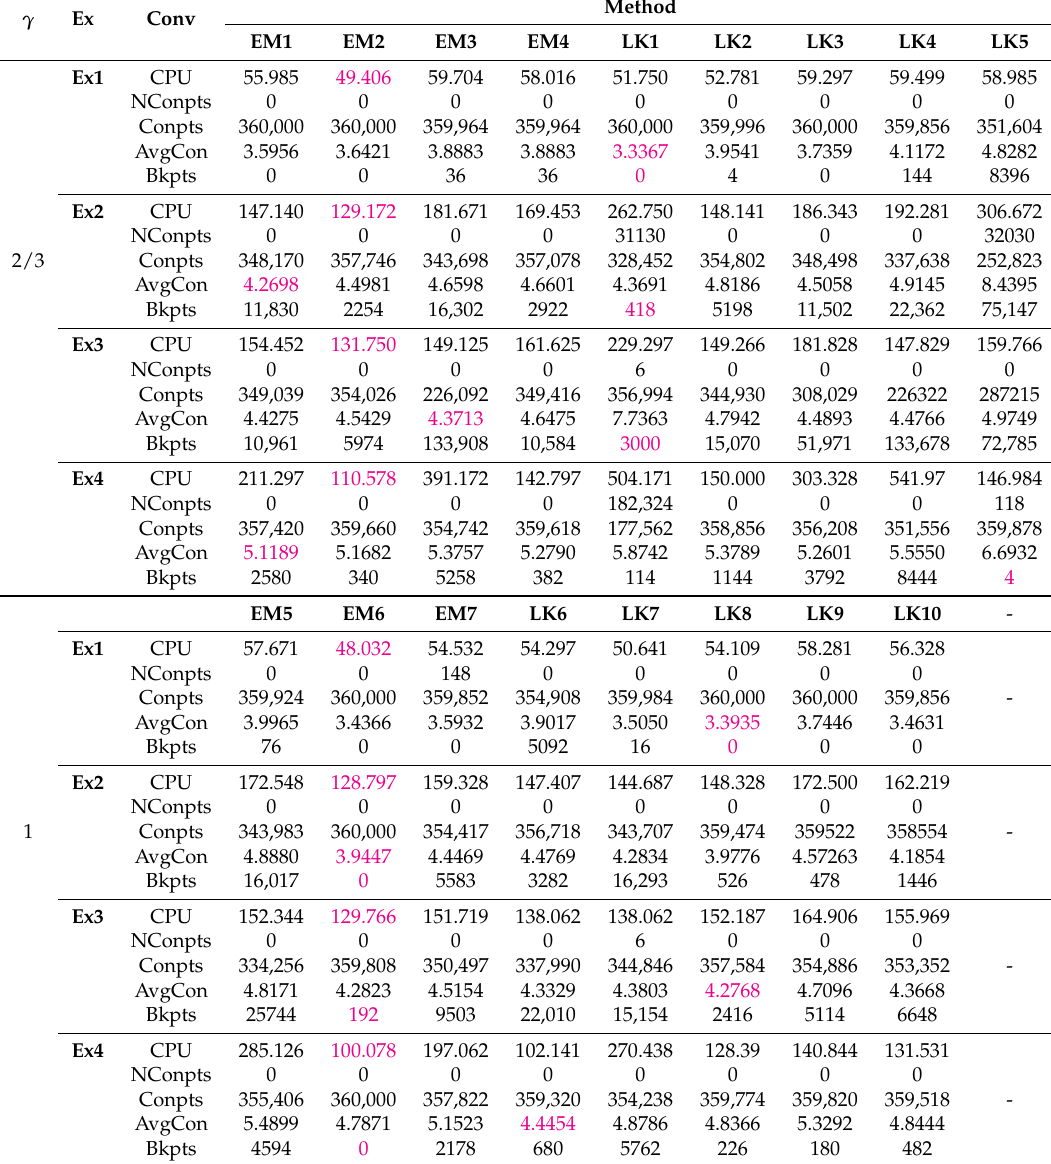
Table 4. Global convergence behavior of selected methods for various